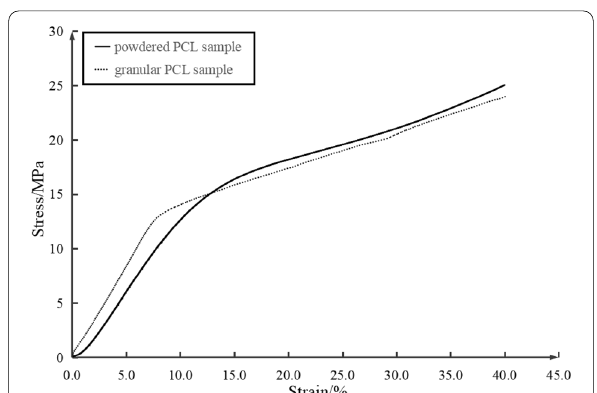
Fig. 9 Uniaxial compression stress–strain curves of PCL specimens of two forms.